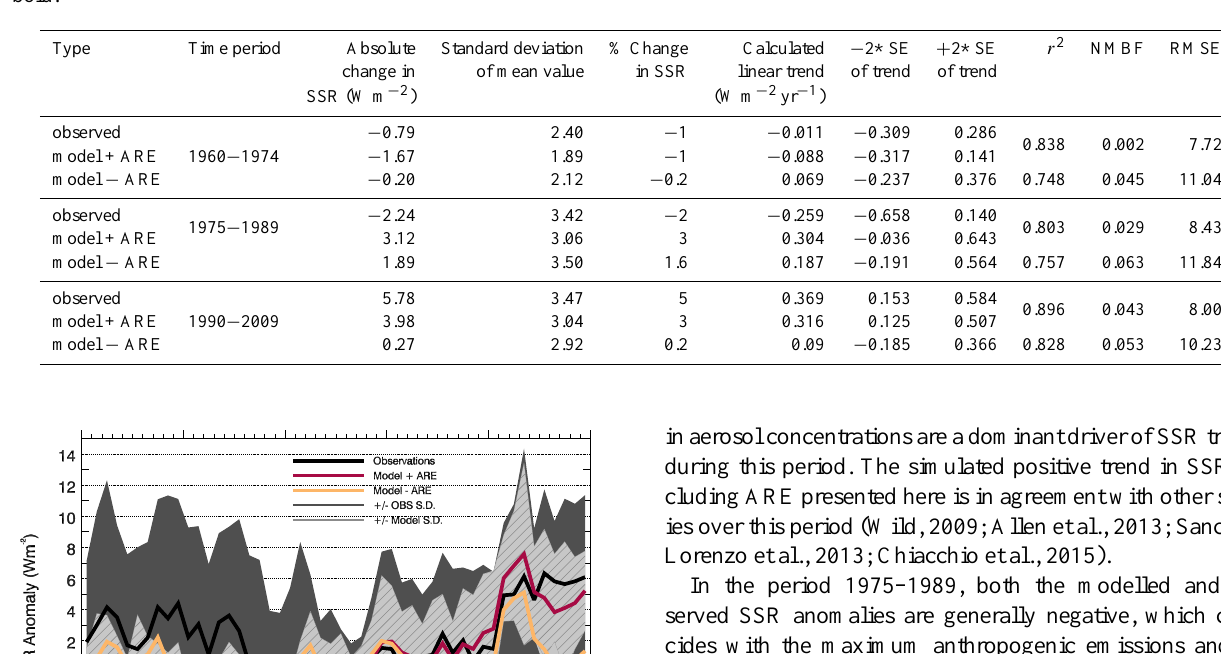
Table 5. Statistical summary of simulated and observed annual mean SSR for three different time periods (1960–1974, 1975–1989 and 1990–2009) at the 20 measurement sites across Europe which have a continuous 50-year data record. Absolute and relative (%) changes in SSR are calculated as the difference between the mean of the initial 5 years of data minus the mean of the last 5 years of data for the time period considered. Trends that are above or below the value of twice of the standard error of the trend (95% confidence) are highlighted in bold.